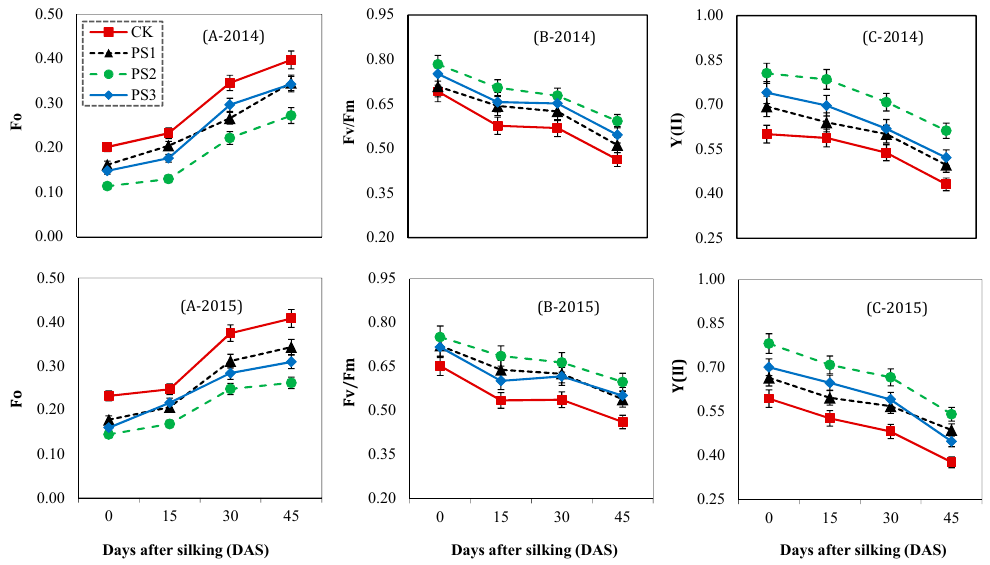
Figure 5. Effects of paclobutrazol treatments on (A) primary fluorescence, Fo (B) maximum quantum efficiency of PSII, Fv/Fm, and (C), actual quantum yield of PSII, Y(II), in maize during 2014 and 2015. Data are presented as mean ± SD of three measurements. Different letters indicate significant differences at P < 0.05 (LSD test). The abbreviations of treatment names are the same as those described in Figure 2.